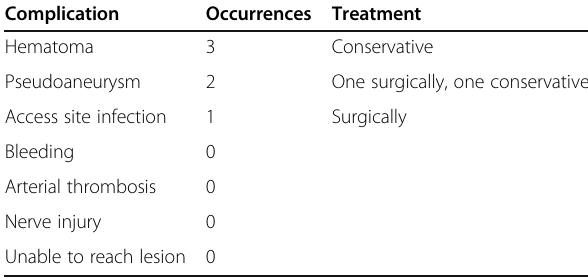
Table 3 In total six complications occurred in 74